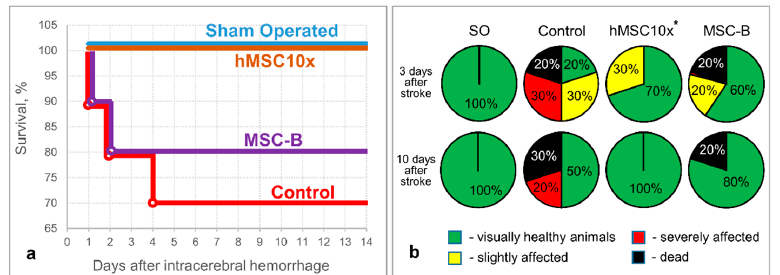
Figure 2. The results of in vivo studies of the neuroprotective activity of the 10 fold-concentrated Figure 1. The results of in vivo studies of the neuroprotective activity of the non-concentrated hu- human MSC secretome (hMSC10x): ( a ) survival of the experimental animals; ( b ) neurological status man MSC secretome (hMSC1x): ( a ) survival of the experimental animals; ( b ) neurological status of of the experimental animals at three and 10 days after the intracerebral hemorrhage (SO—sham the experimental animals (SO—sham operated); and the cognitive status of the experimental ani- operated). Data is presented as a median (25%; 75%). [*— p = 0.006; n ≥ 10; hMSC10x vs Control; two- sided Fisher’s exact test]. days after the intracerebral hemorrhage). The dashed line corresponds to the memory performance of SO animals. Data is presented as a median (25%; 75%). n = 10; no significant differences between the groups.